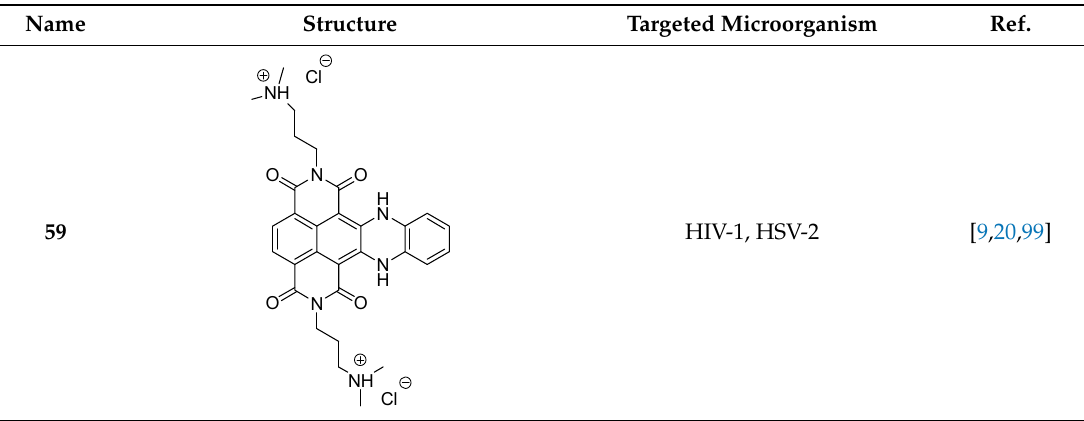
Table 5. Structures of cNDIs used to target G4s in microorganisms.